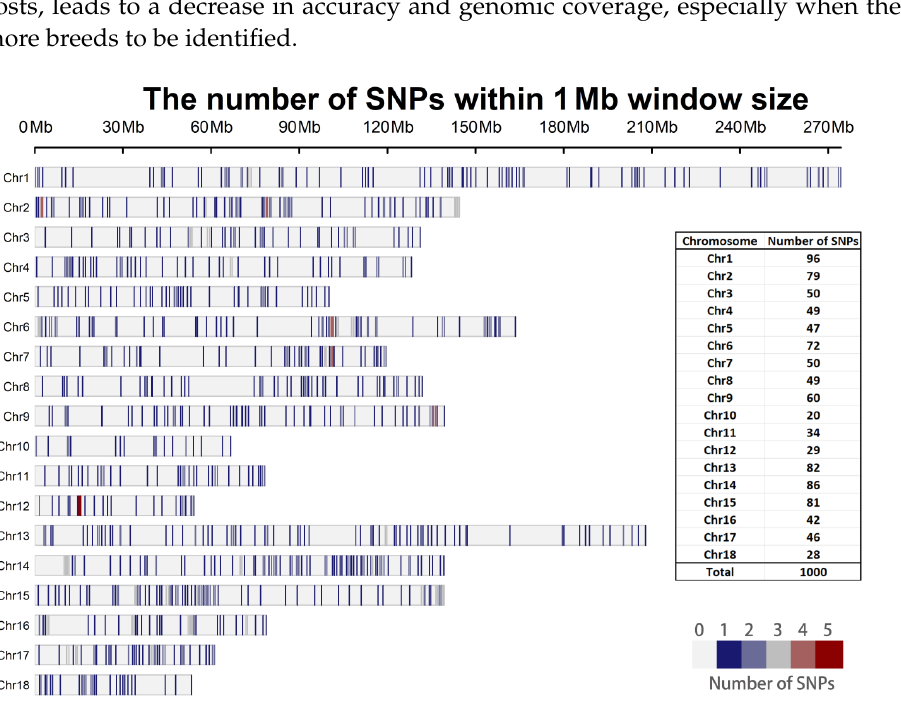
Figure 6. The distribution of 1K SNP panel selected by MDA method on the pig genome. The corresponding pig reference genome is Sscrofa11.1 and the number of SNPs on each chromosome is counted in the table on the right side of the picture.